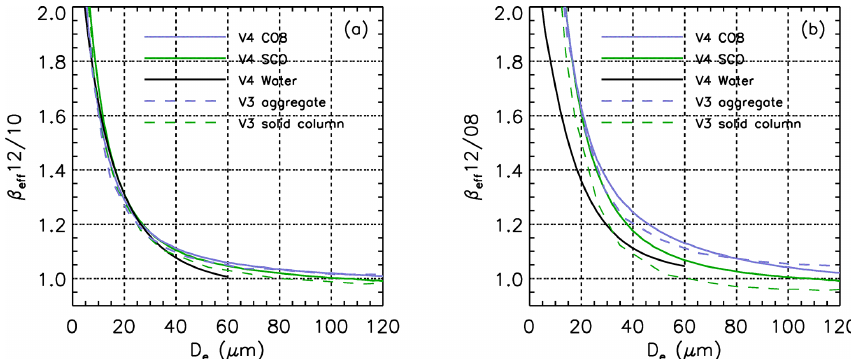
Figure 9. (a) β eff 12 / 10 and (b) β eff 12 / 08 vs. D e using ε eff , 12 = 0 . 23 for the V4 LUTs (solid lines; purple: CO8, green: SCO, black: liquid water) and two V3 LUTs (dashed lines; purple: aggregate, green: solid column).